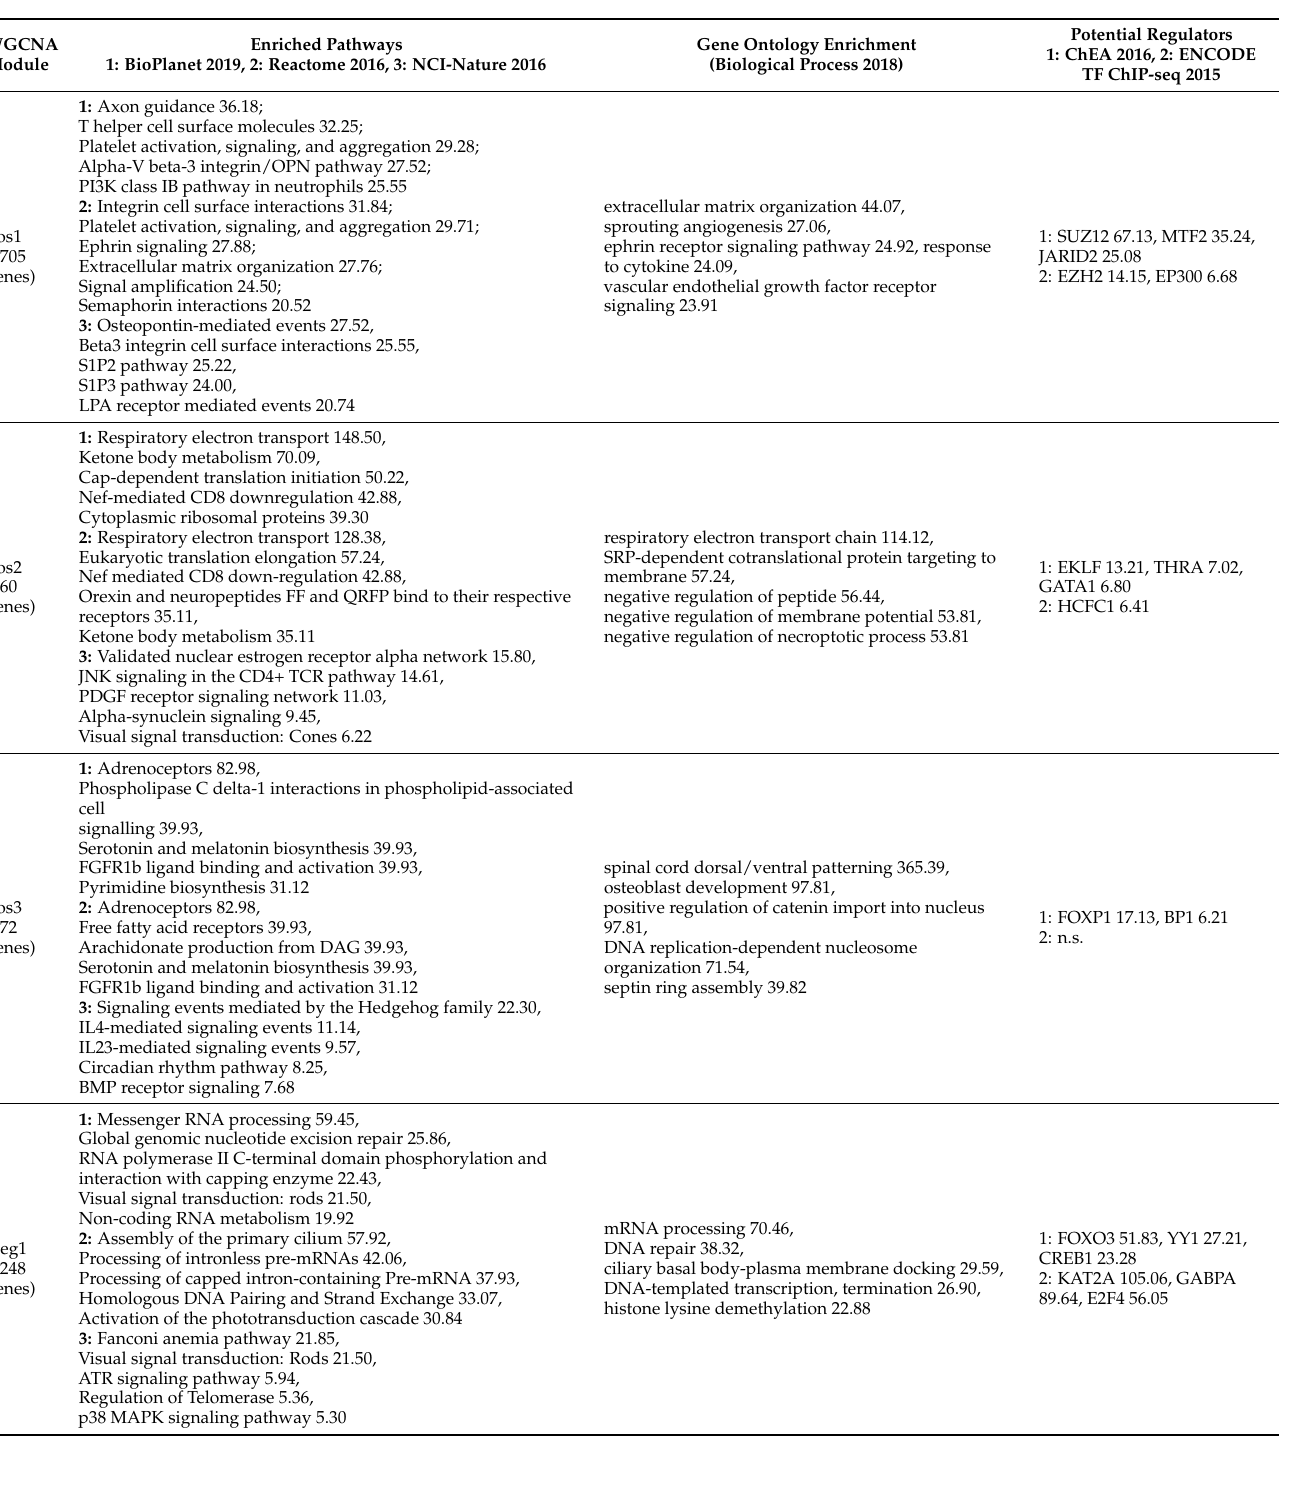
Table 2. Enrichment analysis for WGCNA modules derived from the VPP RNAseq analysis. Enriched pathways and potential upstream regulators were predicted using the indicated databases. For gene ontology enrichment, only the top five non-redundant significantly enriched biological process terms are shown. The numbers following the terms are the combined score as calculated by Enrichr. Only terms with a combined score >5 were considered. Terms in bold font were also identified in the enrichment analysis of the dysregulated gene lists (combined score > 5). n.s. = no significant